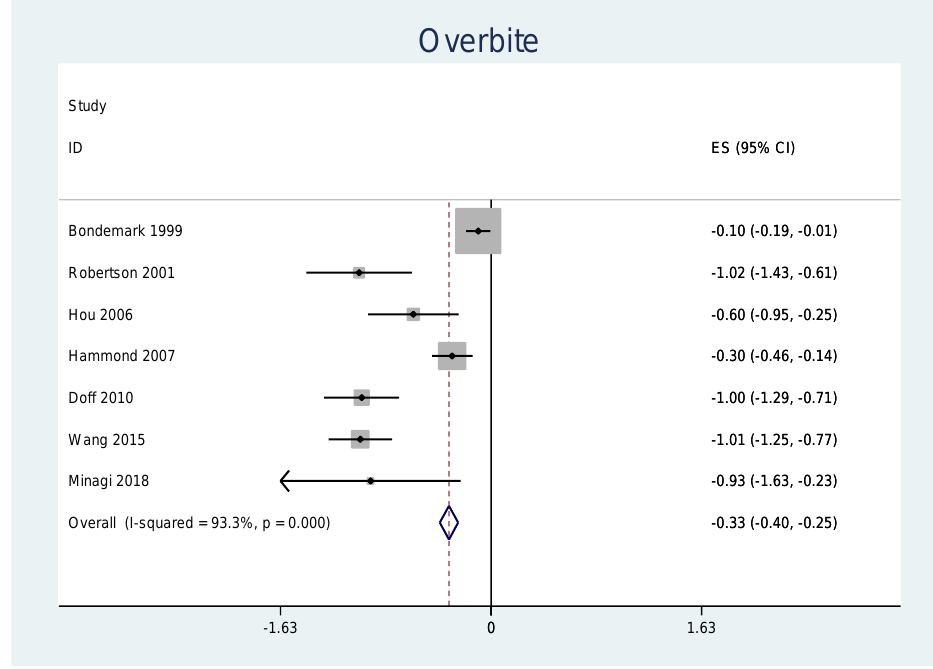
Figure 6. Forest plot of the results of overbite changes using the random-effects model.